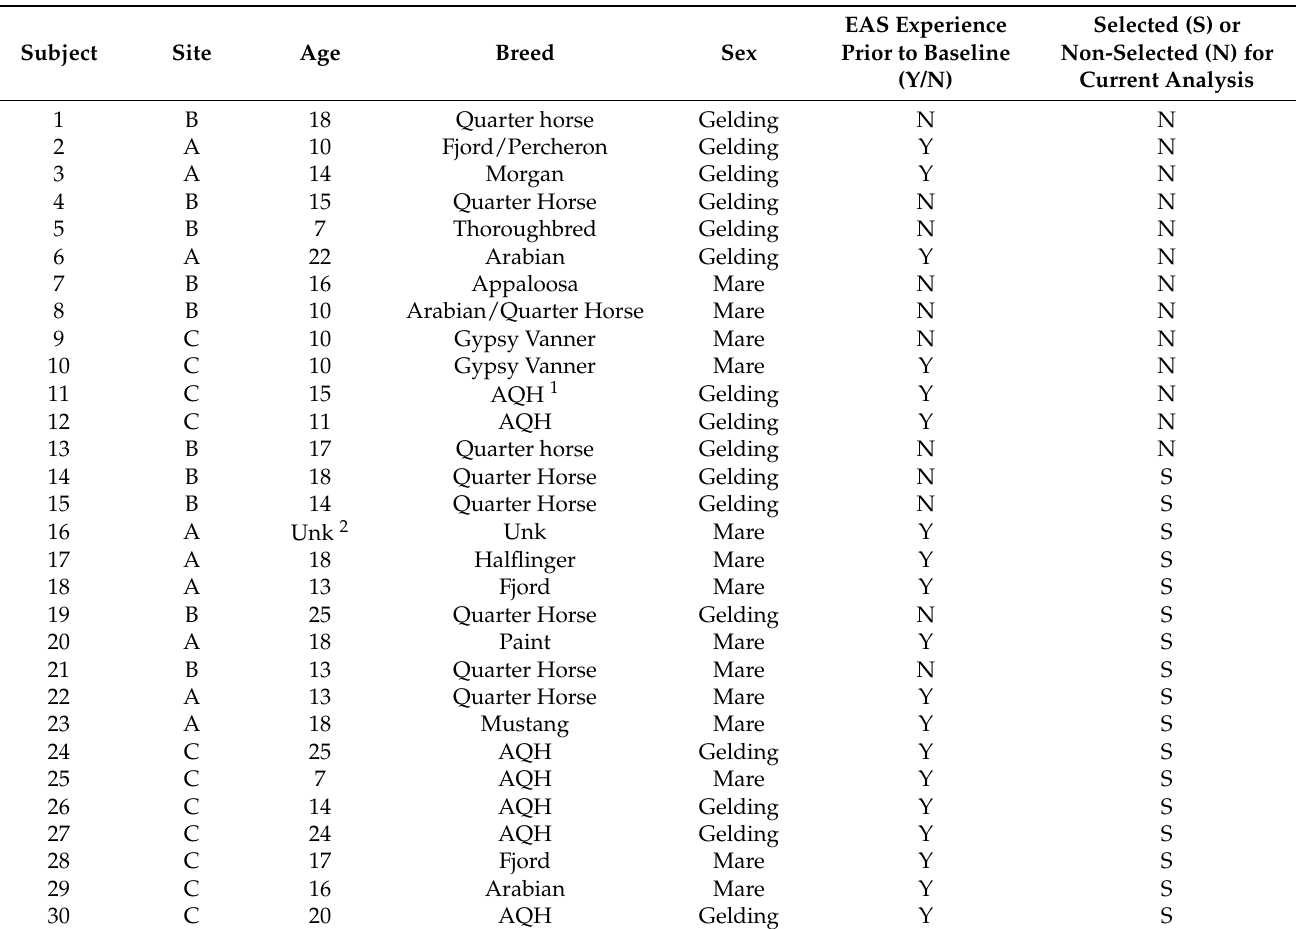
Table 1. Groupings based on whether the horse was experienced in EAS or not and whether the horse was selected for EAS or not. Horse age, breed, sex, and home site are also listed.